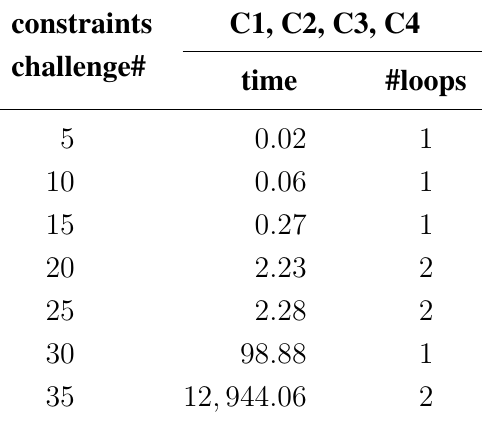
Figure 9. The solution for challenge number 10, where we use a board in Figure